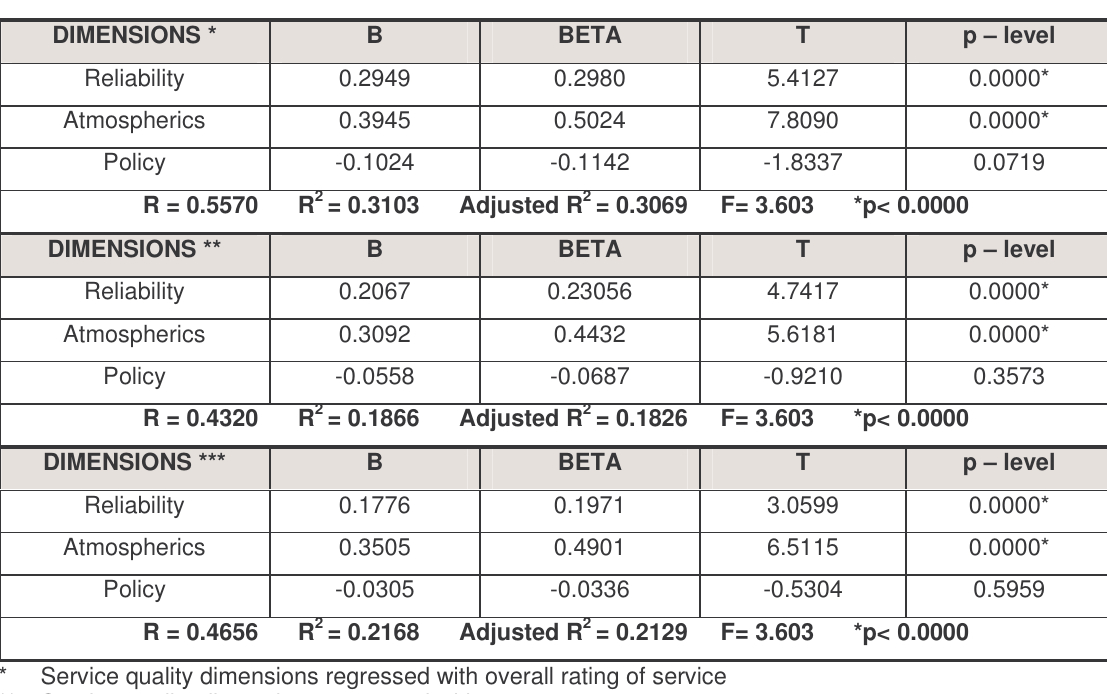
Table 6: Regression Analysis